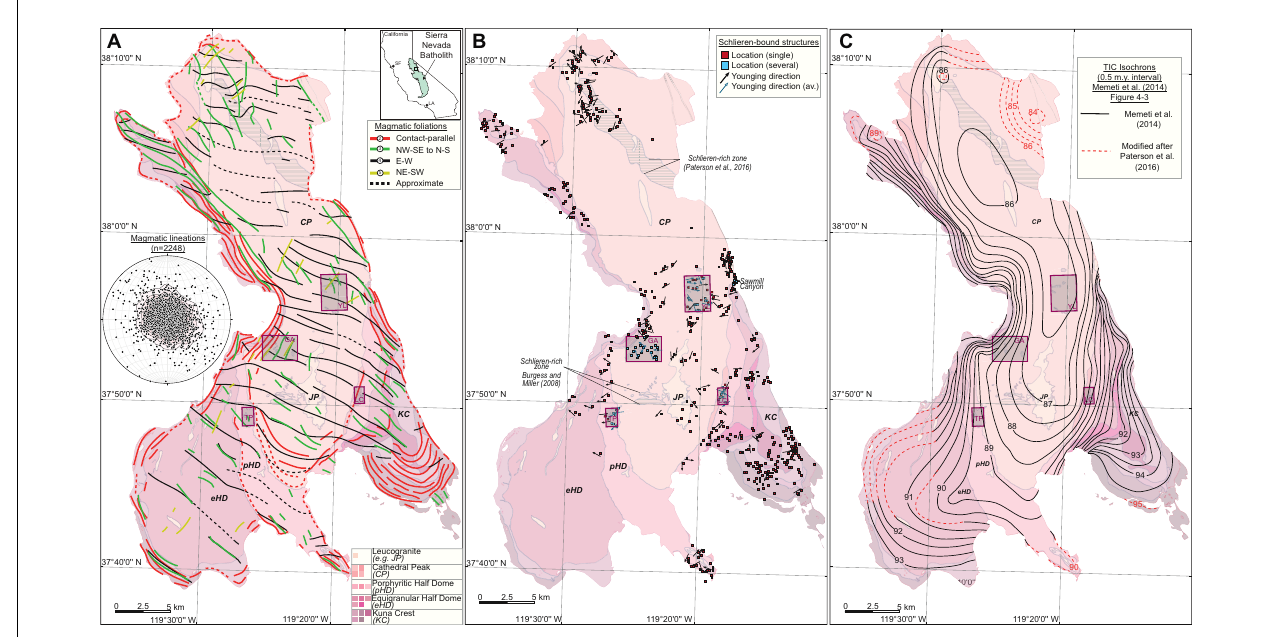
FIGURE 2 | Synthesis of magmatic structures in the Tuolumne Intrusive Complex. (A) Magmatic fabric summary. Foliation data are summarized by trend lines. Lineations are summarized on the stereonet inset. Inset map shows the location of the Tuolumne Intrusive Complex (outlined in box). (B) Map summary of schlieren-bound structural data. Points represent the locations of schlieren-bound structures. Zones of concentrated structures are highlighted in blue, and observations of younging/migration are labeled with arrows. (C) Map summary of U-Pb zircon geochronology after Figure 4-3 in Memeti et al. (2014). Isochrons shown in 0.5 m.y. intervals. Black lines represent contours on the isochron map of Memeti et al. (2014). Red dashed lines denote interpreted modified contours drawn by eye, following ages published in Memeti et al. (2010) and Paterson et al. (2016). Unit abbreviations as follows: KC, Kuna Crest granodiorite;